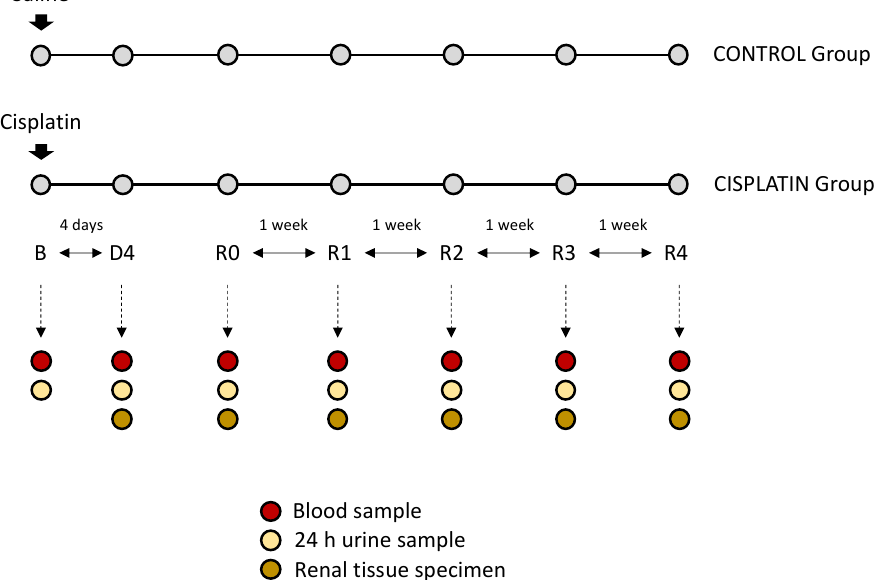
Figure 1. Flowchart of the study design. B: basal timepoint; D4: day of maximum kidney damage after cisplatin treatment; R0: day of recovery; R1: 1 week after recovery; R2: 2 weeks after recovery; R3: 3 weeks after recovery; R4: 4 weeks after recovery.